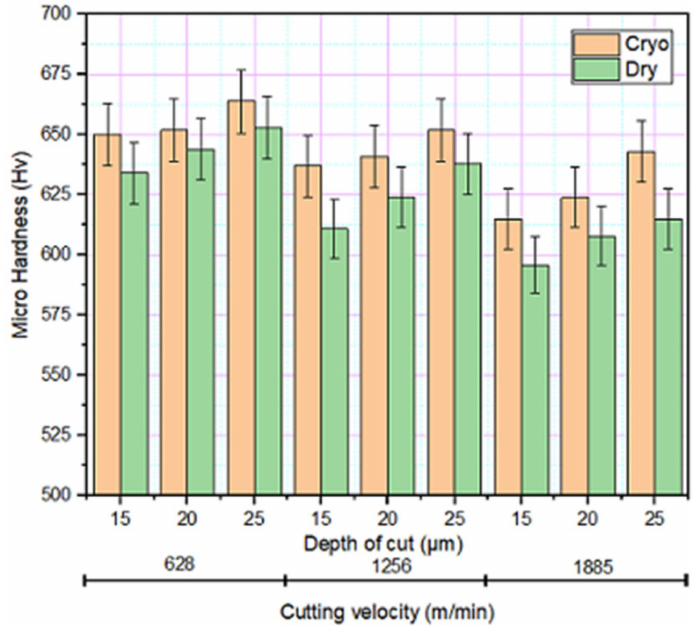
Figure 6. Variation of microhardness at different grinding